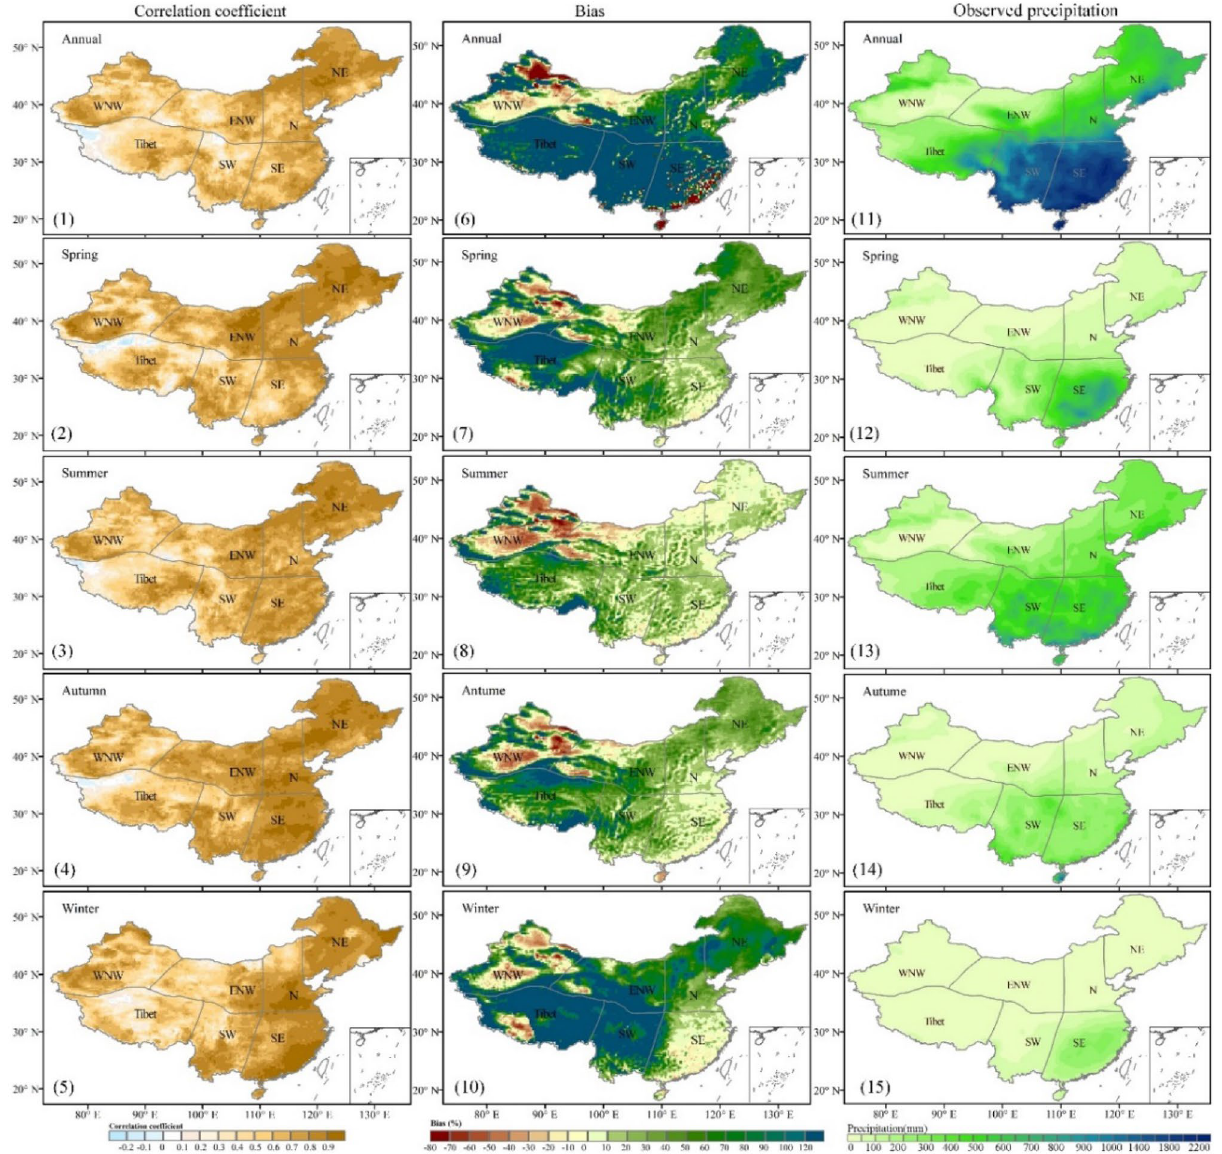
Figure 4. The correlation coefficient (CC) (left panel, (1)–(5)) and Bias (middle panel, (6)–(10)) between the ERA5 and observed precipitation data (right panel, (11)–(15)) during 1979–2018 in Chinese mainland (ArcGIS Desktop. 10.0. ESRI, California, US. https:// deskt op. arcgis. com/ zh-